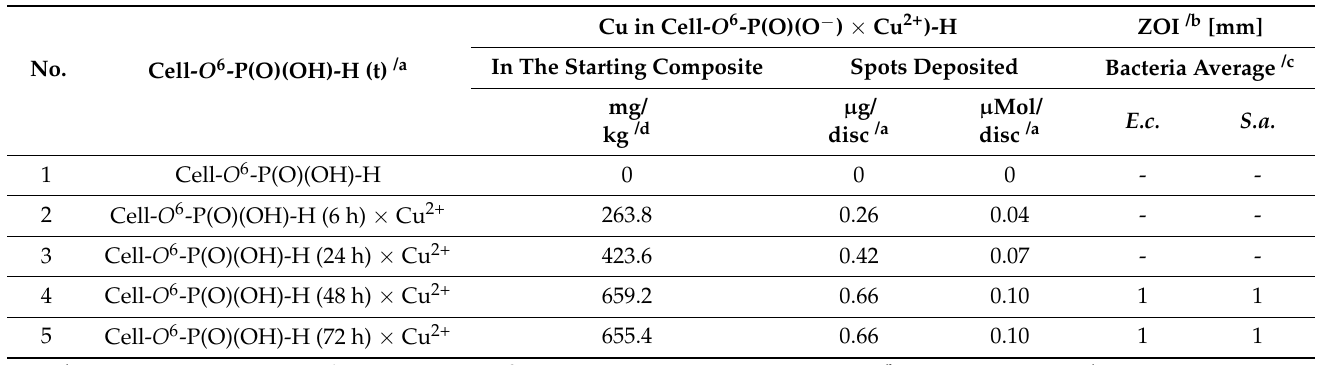
Table 11. Results of tests on the antibacterial activity of Cell- O 6 -P(O)(O − )-H × Cu 2+ complexes, according to standard EN-ISO 20645:2006 [78].